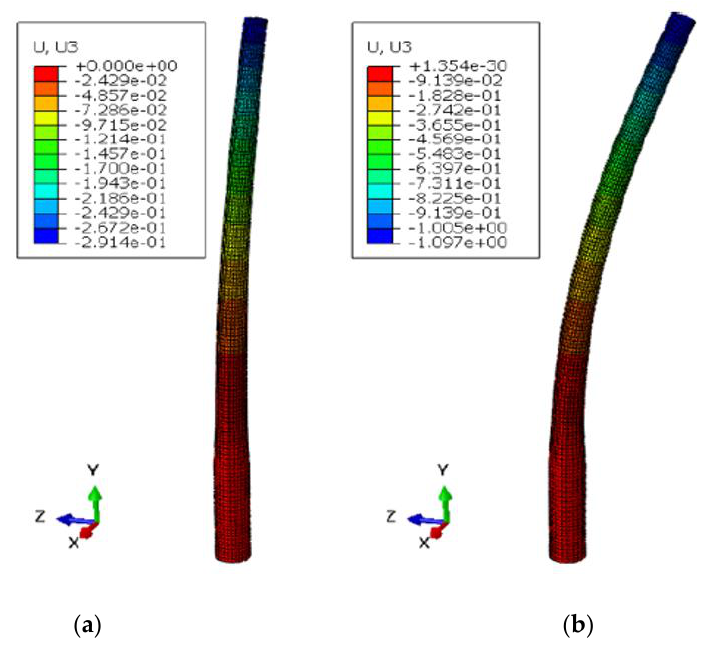
Figure 7. Lateral displacement: ( a ) Normal conditions, ( b ) Extreme sea state.